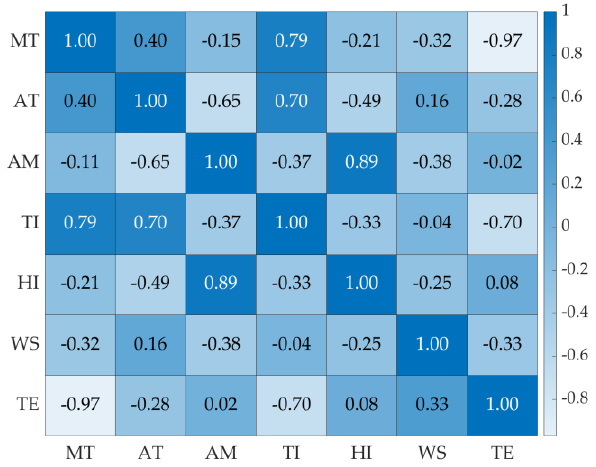
Figure 7. Correlation thermodynamic diagram.